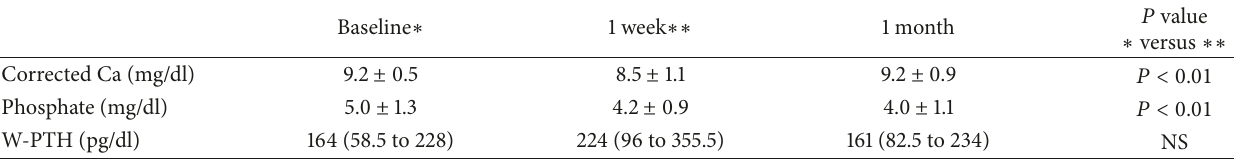
Table 3: Serum albumin-corrected calcium, P, and whole-PTH levels during the denosumab treatment course.